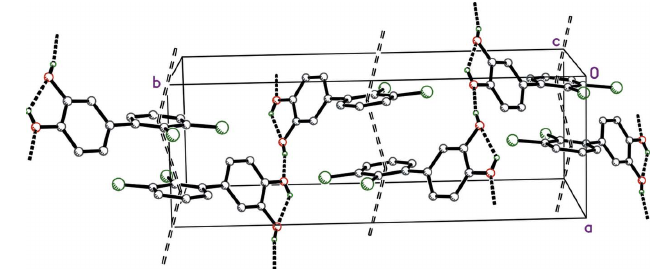
Figure 2 A packing plot viewed approximately along the c axis. Hydrogen bonds (Table 1) are drawn as solid dashed lines, and the (cid:2) – (cid:2) interactions are depicted as dashed open lines between the centroids of stacked rings.